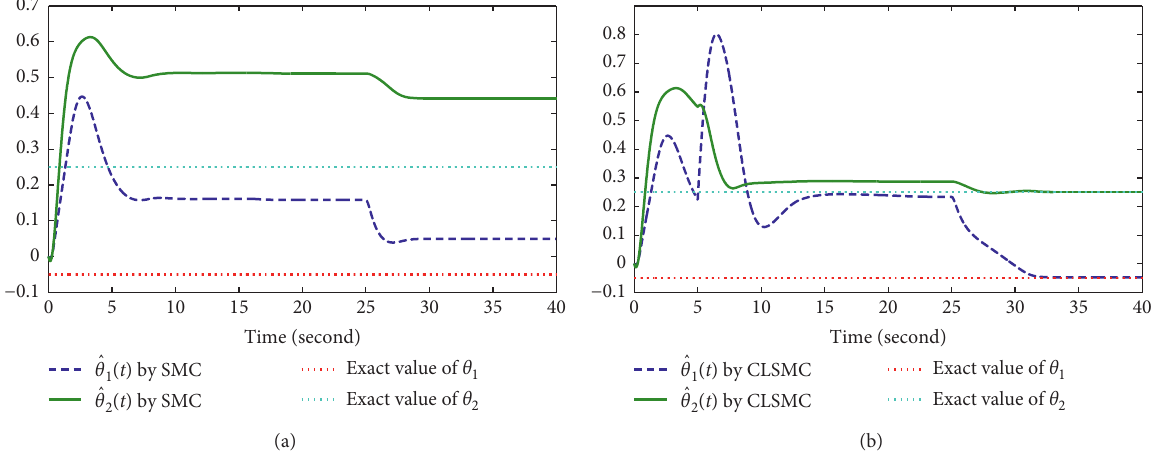
Figure 1: Parameter evaluations under SMC and CLSMC.